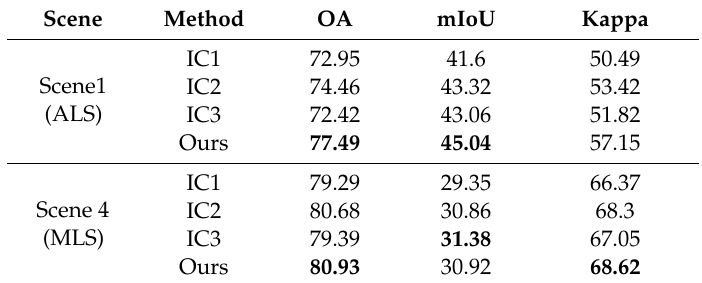
Table 11. Classification results of classification models with di ff erent configurations on Scene1 and Scene4 (%). Note the highest accuracy values are highlighted in